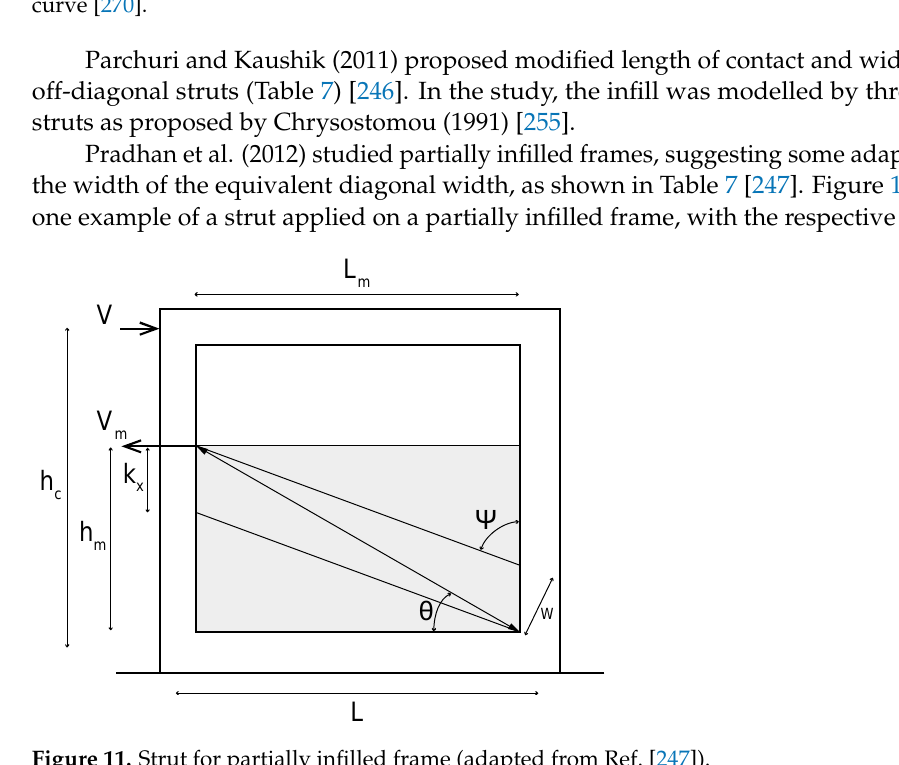
Figure 11. Strut for partially infilled frame (adapted from Ref. [247]).